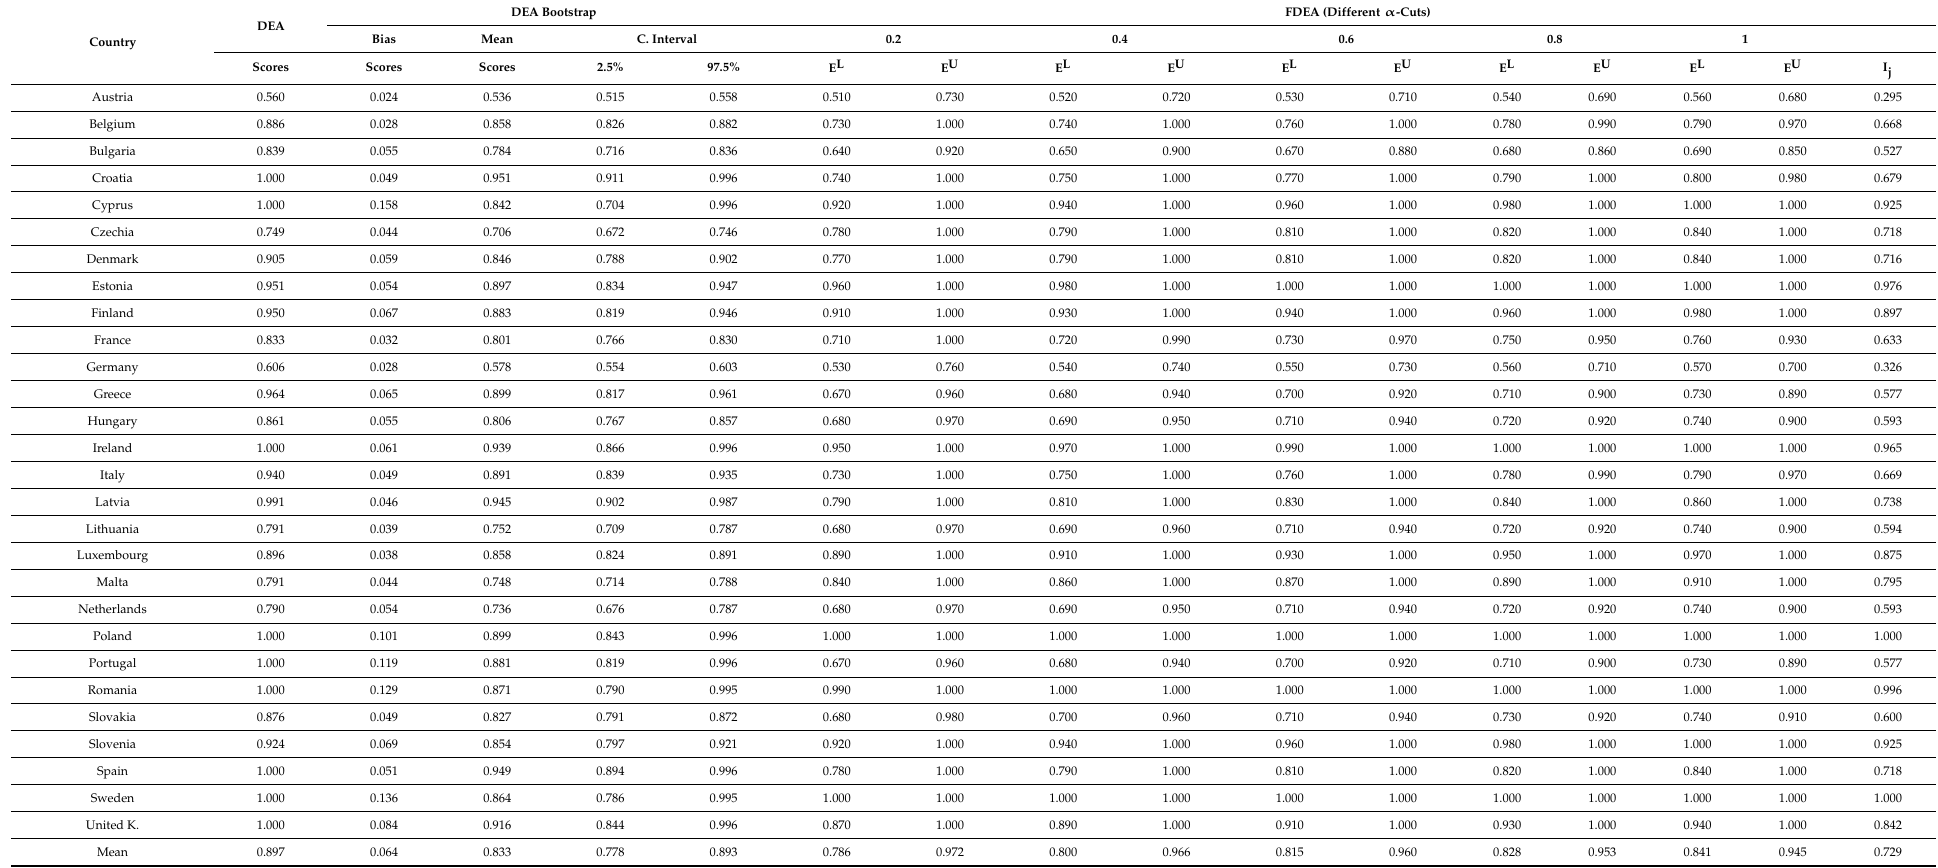
Table 4. Efficiency scores according to the different models and α